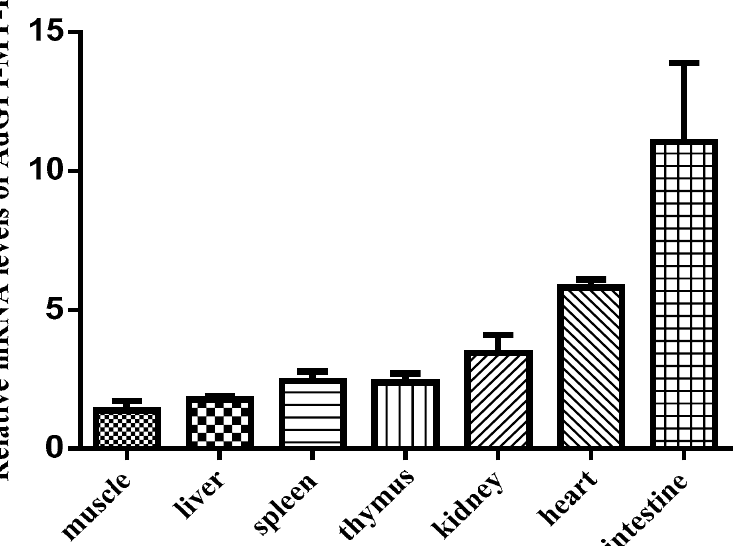
Figure 4. The mRNA transcription levels of AdGPI-MT-I in six healthy Chinese giant salamander tissues including muscle, liver, spleen, thymus, kidney, heart, and intestine. The mRNA expression of AdGPI-MT-I was detected by quantitative real-time PCR (qRT-PCR), which was normalized to β -actin. The expression level in muscle was set as 1. Data are the means of three independent assays and are presented as means ± SD.